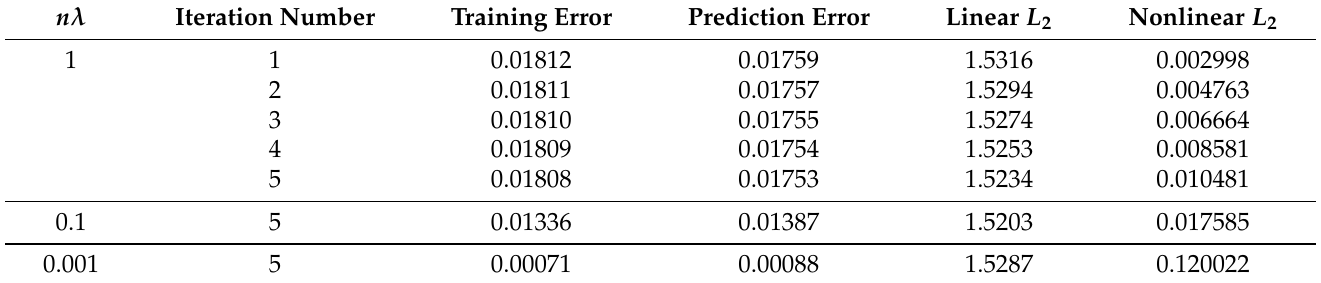
Table 4. Simulation results when (cid:101) ∼ N ( 0,0.01 ) . The third column shows the mean squared prediction error on the training points. The fourth column shows the mean squared prediction error on the testing points. The fifth column and the last column show the approximated L 2 norm of ˆ f and ˆ g as in (20),